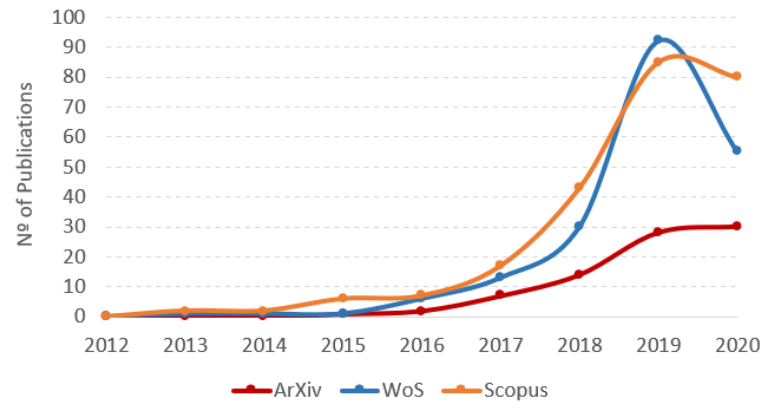
Figure 2. Research works published by year addressing registration of 3D data with learning approaches in each source (data obtained through the search engines of each source through September